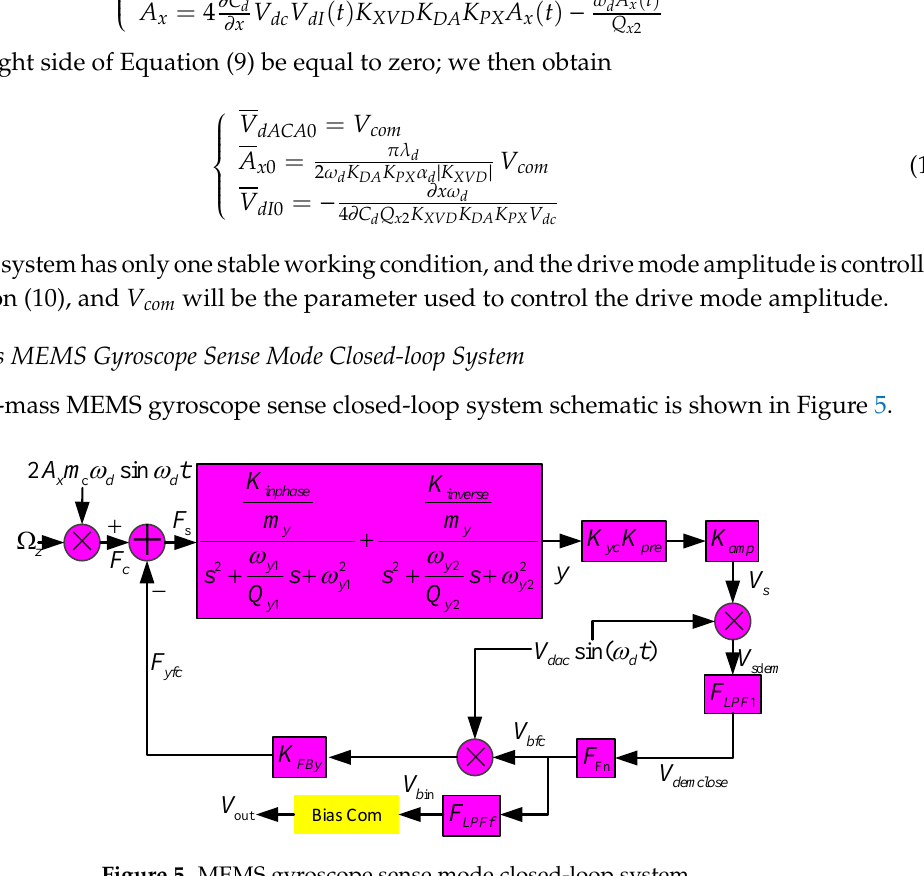
Figure 5. MEMS gyroscope sense mode closed-loop system.